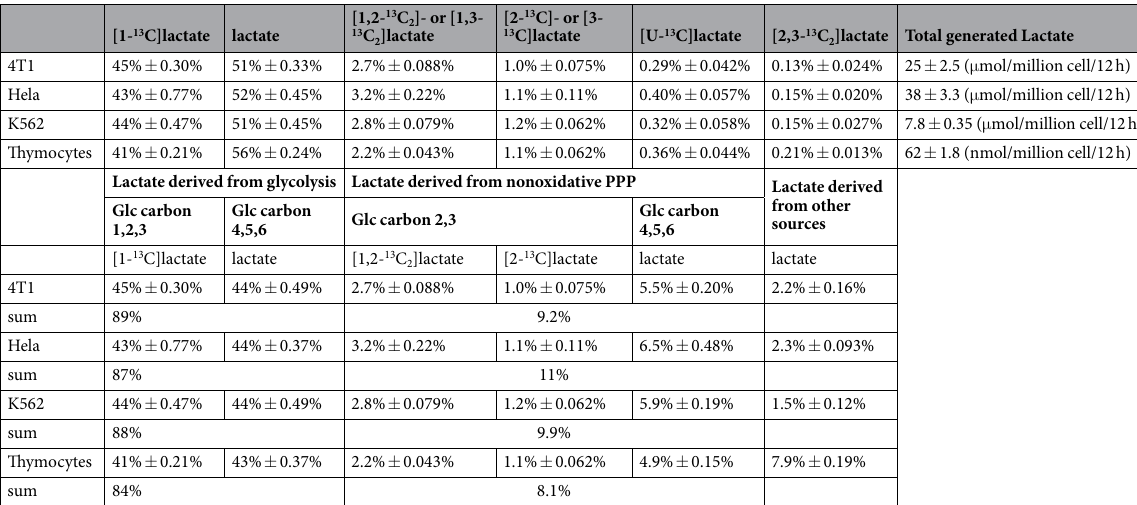
Table 3. The percentage of lactate isotopomers and isotopologues (mean ± SD, n = 12) generated by 4T1, Hela, K562, and thymocytes, traced by [3- 13 C]glucose (upper part), the percentage of lactate (mean ± SD, n = 12) derived from glycolysis, PPP and other sources (down part). 4T1, Hela, K562 and thymocyte were incubated in serum-free RPMI-1640 medium containing 6 mM [3- 13 C]glucose for 12 hours in a humidified CO 2 incubator and culture supernatant was collected for LC-MS/MS analysis as described in Materials and Methods. The upper part summarizes the percentage of each lactate isotopologues. The down part assigned the percentage of isotopologues that are generated from glycolysis, pentose phosphate pathway, and other sources. Specifically, the percentage of lactate is contributed by three parts, from glycolysis, pentose phosphate pathway (calculated based on percentage of [2- 13 C]- and [1,2- 13 C 2 ]lactate as described in corresponding text), and other sources (according to percentage listed in Table 1). Data are mean ± SD, n = 12, from 2 independent